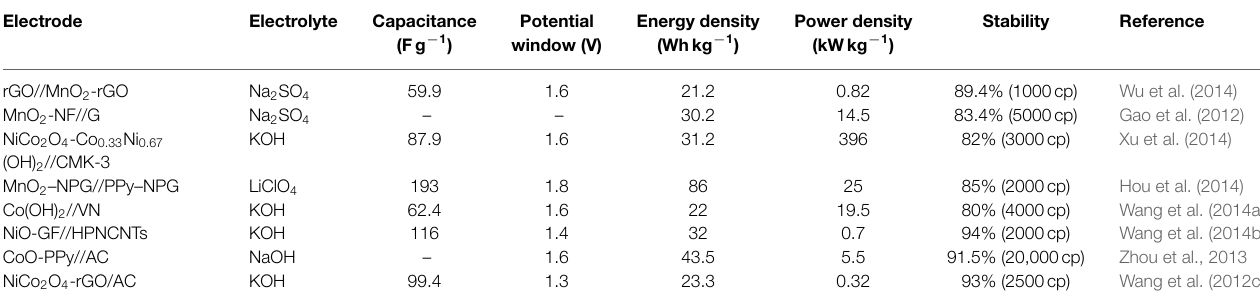
TABLE 3 | Electrochemical performance of the asymmetric supercapacitors based on new electrode materials